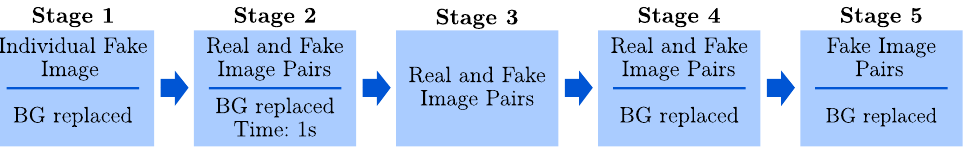
Figure 7. Validation stages of the Mechanical Turk.